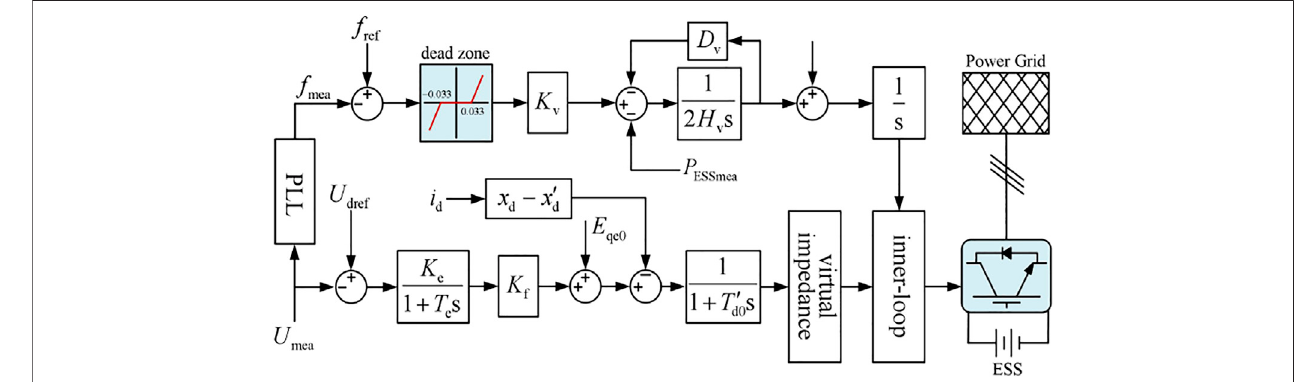
FIGURE 1 | Control block diagram of the ESS.